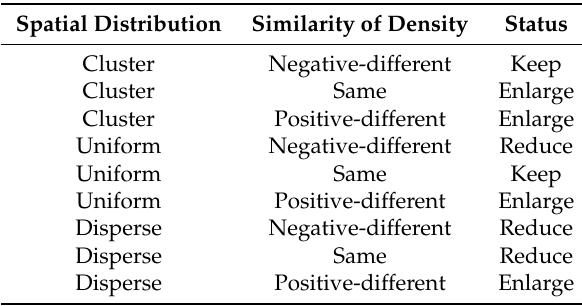
Algorithm 3: Size adjustment for contention